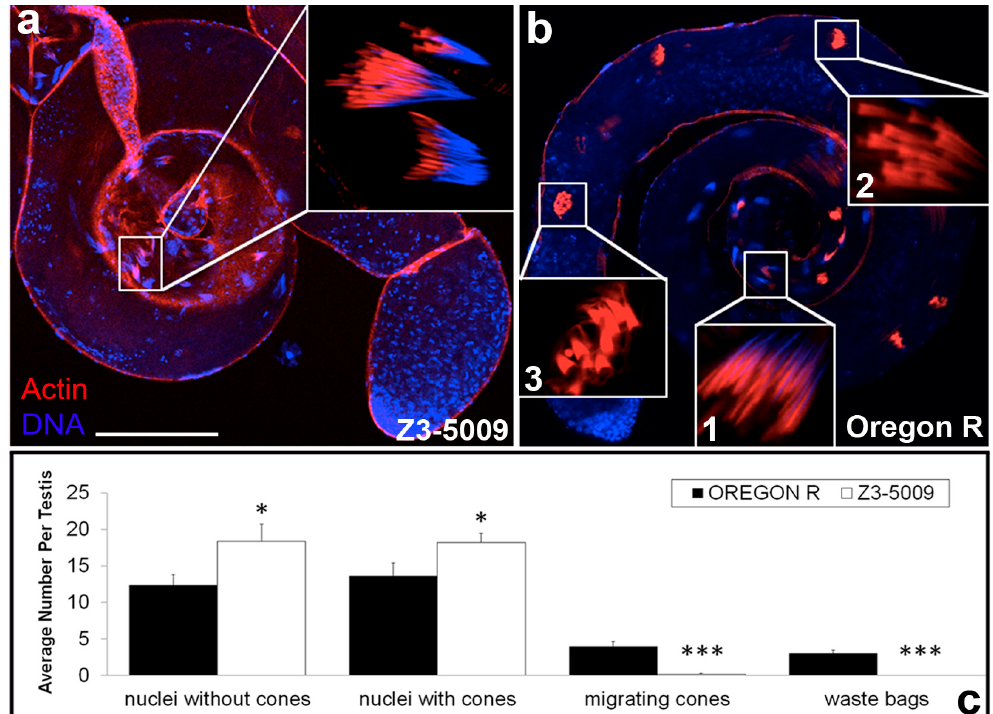
Figure 1. Spermatid individualization is disrupted in Z3-5009 mutant. Actin cone complexes in Z3-5009 testes ( a ) form in association with spermatid nuclei but do not progress past this stage (inset). In Oregon R control testes ( b ), actin cones form in association with sperm nuclei (inset 1), travel synchronously down the axonemes driving progress of spermatid individualization (inset 2, 3), and break down in a cystic bulge; phalloidin staining, red; DAPI staining, blue. ( c ) Classification of actin cone phenotype in control Oregon R ( n = 13, black) and Z3-5009 mutant ( n = 16, white); the average number of actin cones falling into each phenotypic class is reported. Bar 100 µm. * p < 0.05; *** p < 0.001.